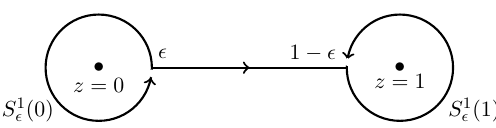
Figure 7. Regularization of the path [0 , 1] . S 1